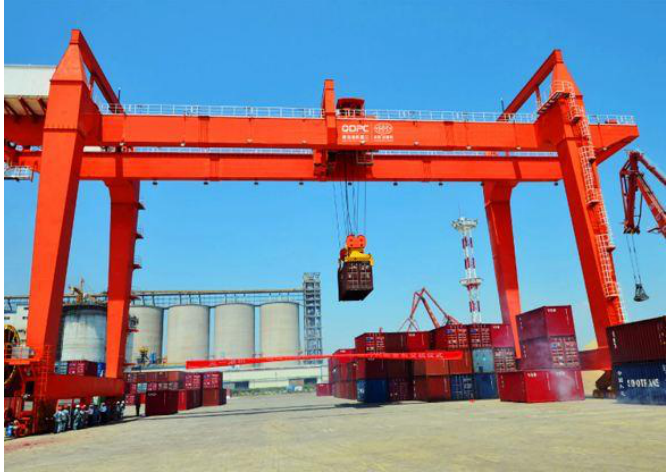
Figure 1. A real crane diagram with hoist and load.